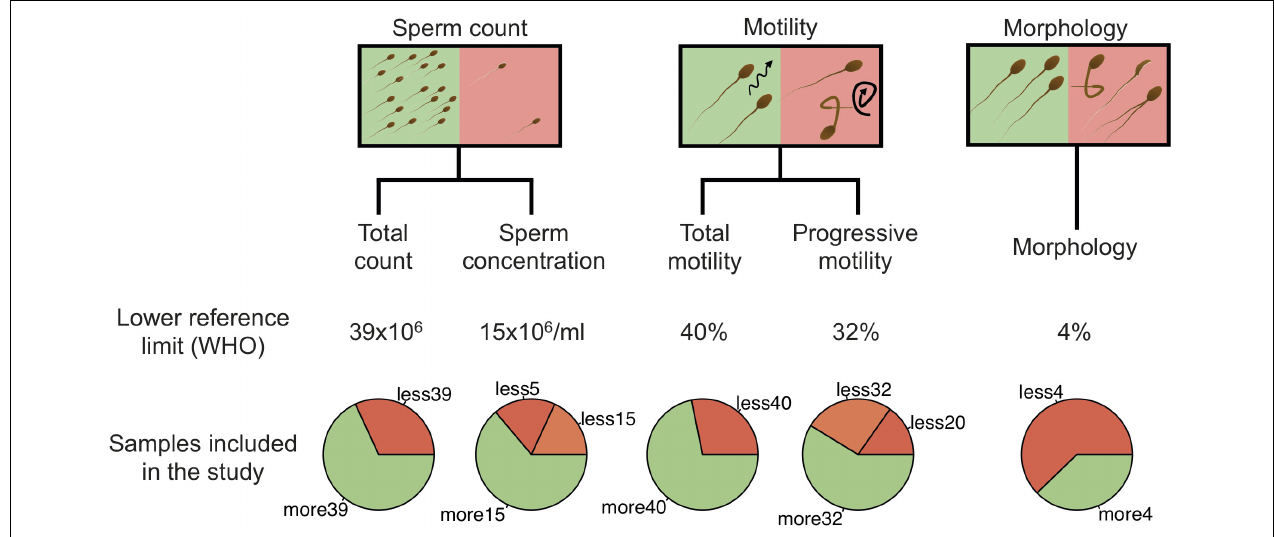
FIGURE 1 | Schematic representation of sample stratification. In addition to the spermiogram status, five categories, including total sperm count, sperm concentration, total motility, progressive motility and morphology were analyzed independently by comparing normal and abnormal values. For sperm concentration and progressive motility categories, abnormal values were further separated into two classes (abnormal and severe). Lower reference limits, defined by the WHO, are shown for each category.